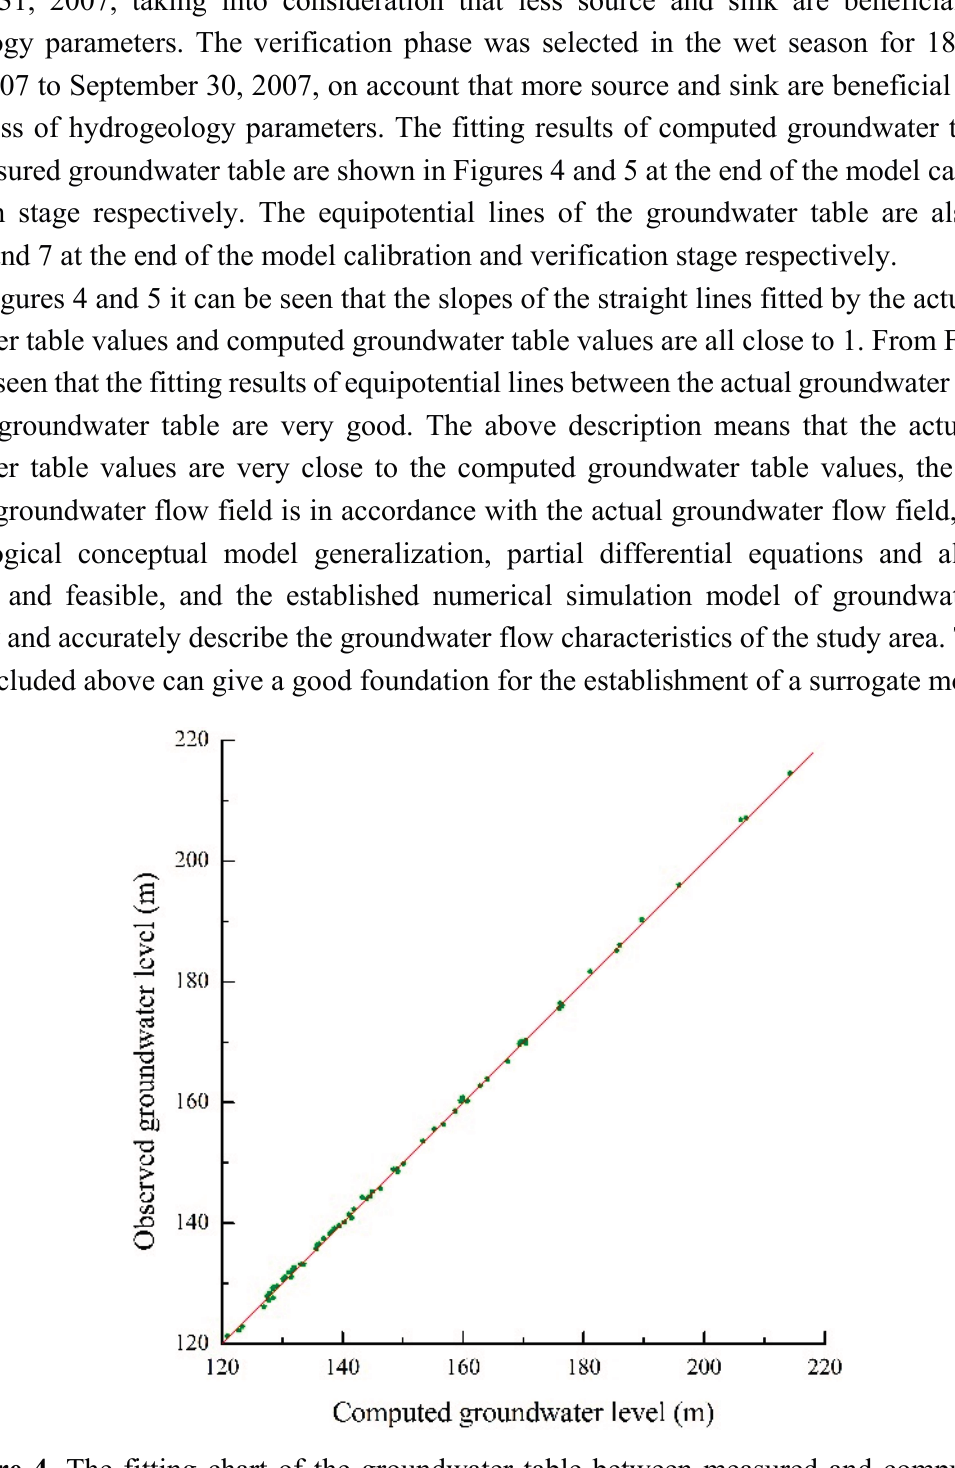
Figure 4. The fitting chart of the groundwater table between measured and computed of each observation well at the end of the model calibration